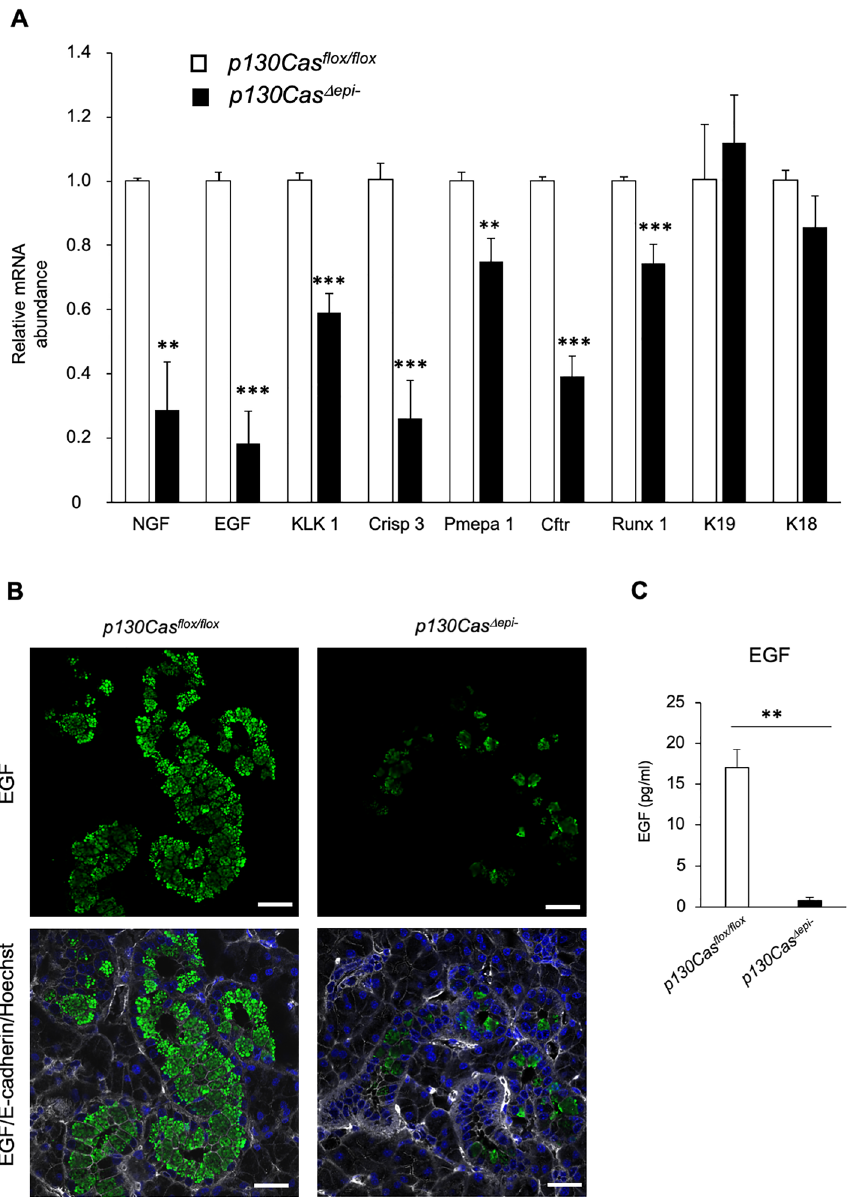
Figure 5. AR signaling is associated with the maturation defects in the GCT of SMG in p130Cas Δepi- mice. ( A ) Quantitative real-time PCR analysis of relative mRNA abundance in the SMG in P42 male p130Cas flox/flox and p130Cas Δepi- mice for NGF, EGF, KLK 1, Crisp 3 , Pempa 1 , Ctfr, Runx 1, K19, and K18. ( B ) Representative immunofluorescence staining of SMG paraffin sections using anti-EGF (green) and anti-E-cadherin (grey). Nuclei were counterstained using Hoechst 33,342. Scale bars = 25 µm. ( C ) EGF level in the saliva from male p130Cas flox/flox and p130Cas Δepi– mice was measured using an enzyme-linked immunosorbent assay kit. p130Cas flox/flox n = 9 mice, and p130Cas Δepi- n = 6 mice. Data show the mean ± SEM, ** P < 0.01, *** P < 0.001 versus the corresponding p130Cas flox/flox